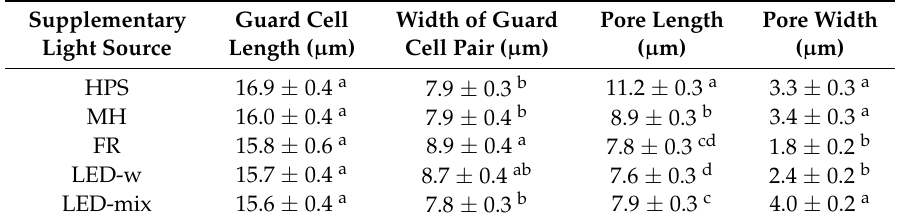
Table 2. Guard cell length, width of guard cell pair, and stomatal pore length and width in leaves of C. lanceolata seedlings as affected by supplementary light sources. Different alphabets indicate the significant separation within columns by Duncan’s multiple range test at a 0.05 level.